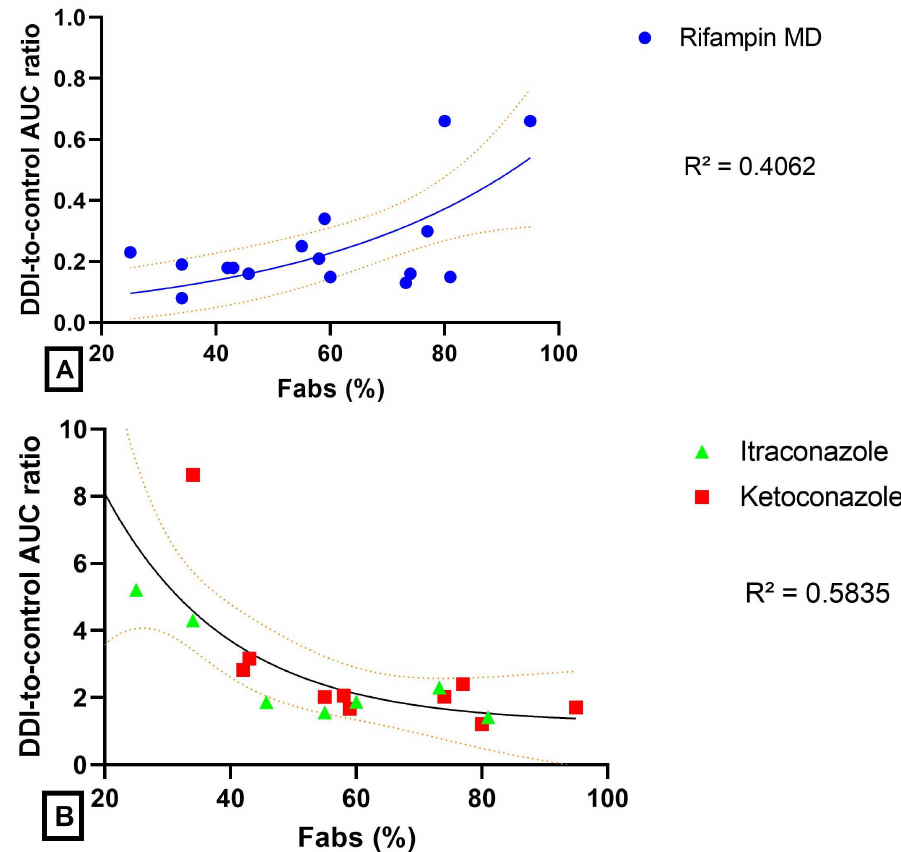
Figure 3. Magnitude of the DDI (estimated by the DDI-to-control AUC ratio) as a function of the oral absolute bioavailability (Fabs, %) ( A ): rifampin DDI studies (blue circle). ( B ): ketoconazole DDI studies (red square) and itraconazole DDI studies (green triangle). The coefficient of determination R 2 is indicated for each relationship, and the 95% confidence interval is represented on each plot.